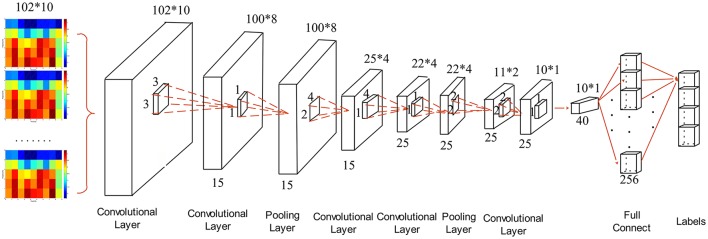
Structure of single CNN used for MWL classification.